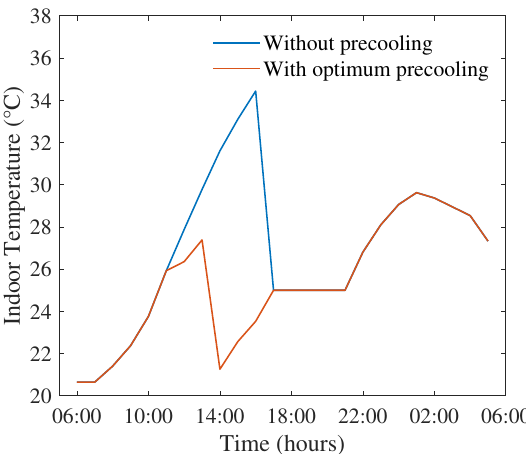
Figure 5. Indoor temperature with and without optimum pre-cooling on 8 January 2013.